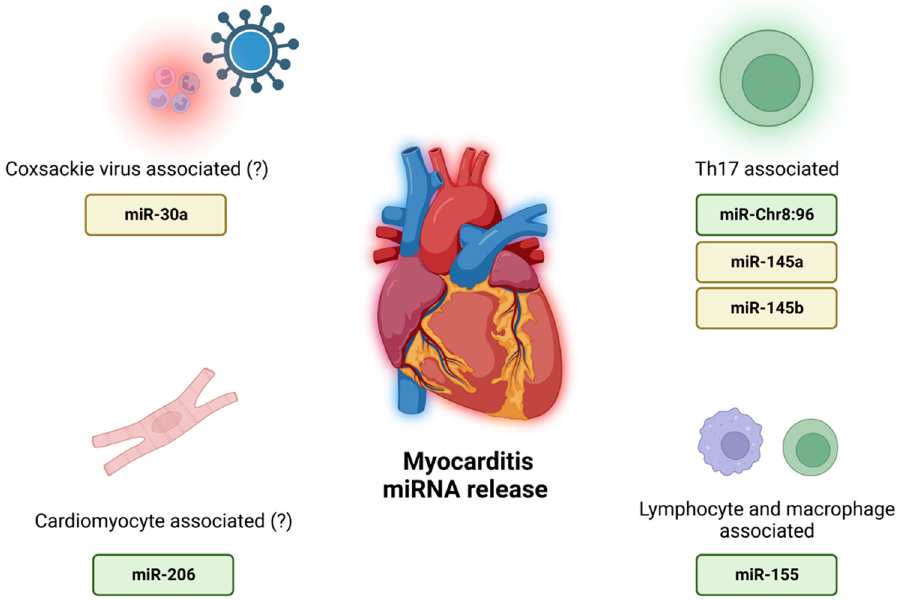
Figure 3. Sources of the proposed miRNAs; biomarker candidates are shown in green boxes, and potential biomarker candidates are shown in yellow boxes. Created with BioRender.com. Accessed on 7 September 2022.